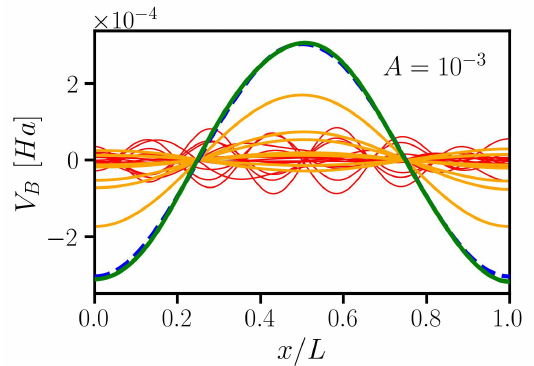
Figure 10: Comparison of quantum Bohm potentials of the correlated electrons gas = 2). The deviations of the standard in the limit of weak perturbation ( θ = 1 and r s Bohm potential (dashed blue) from the exact many-fermion quantum Bohm potential (green) are shown. The individual contribution of orbitals with one maximum in the center (orange) and with more that one maximum (red) are also